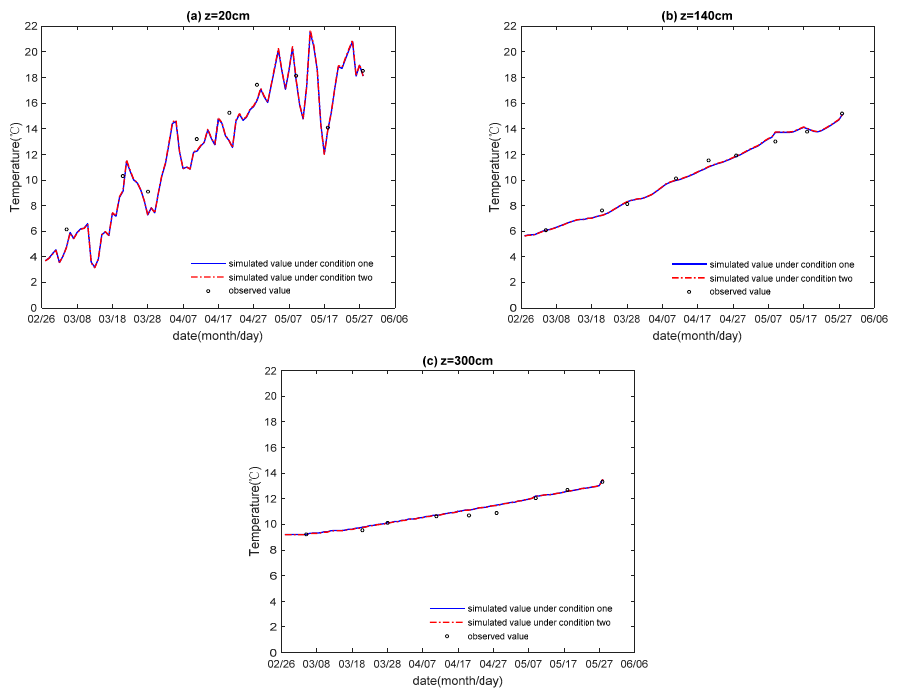
Figure 7. Comparison between simulated and observed values for soil temperature with time at different soil depths under conditions one and two.